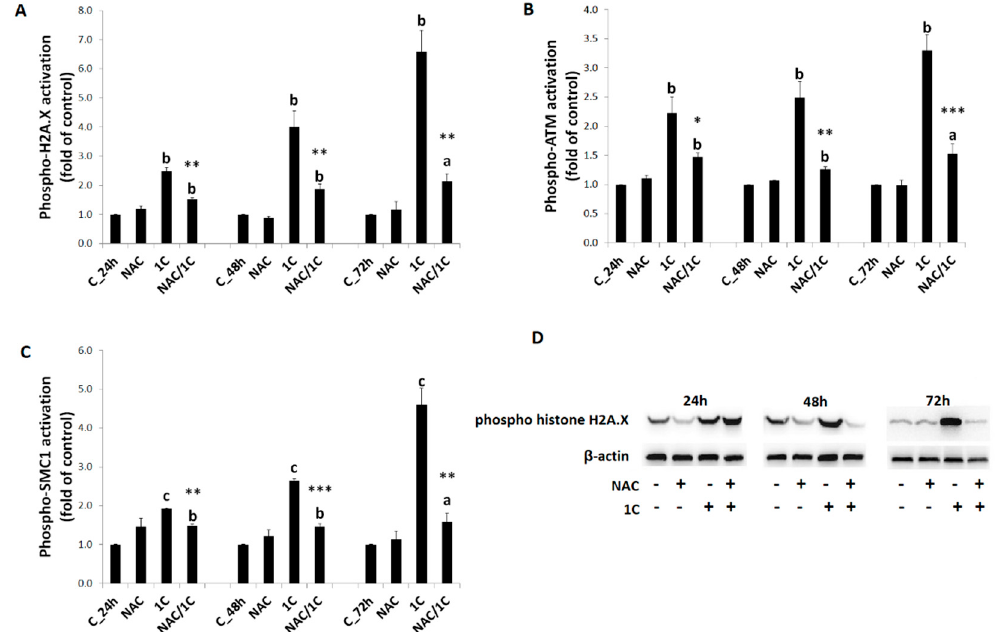
Figure 10. Analysis of DNA damage-related proteins. Phospho histone H2A.X ( A , D ), phospho-ataxia telangiectasia mutated kinase (ATM), ( B ) and phospho-structural maintenance of chromosomes 1 (SMC1) ( C ) levels after 24, 48, and 72 h of 1C or NAC/1C treatment. Significantly different a p < 0.05, b p < 0.01, c p < 0.001 vs. untreated cells (control); * p < 0.05, ** p < 0.01, *** p < 0.001 vs. 1C.